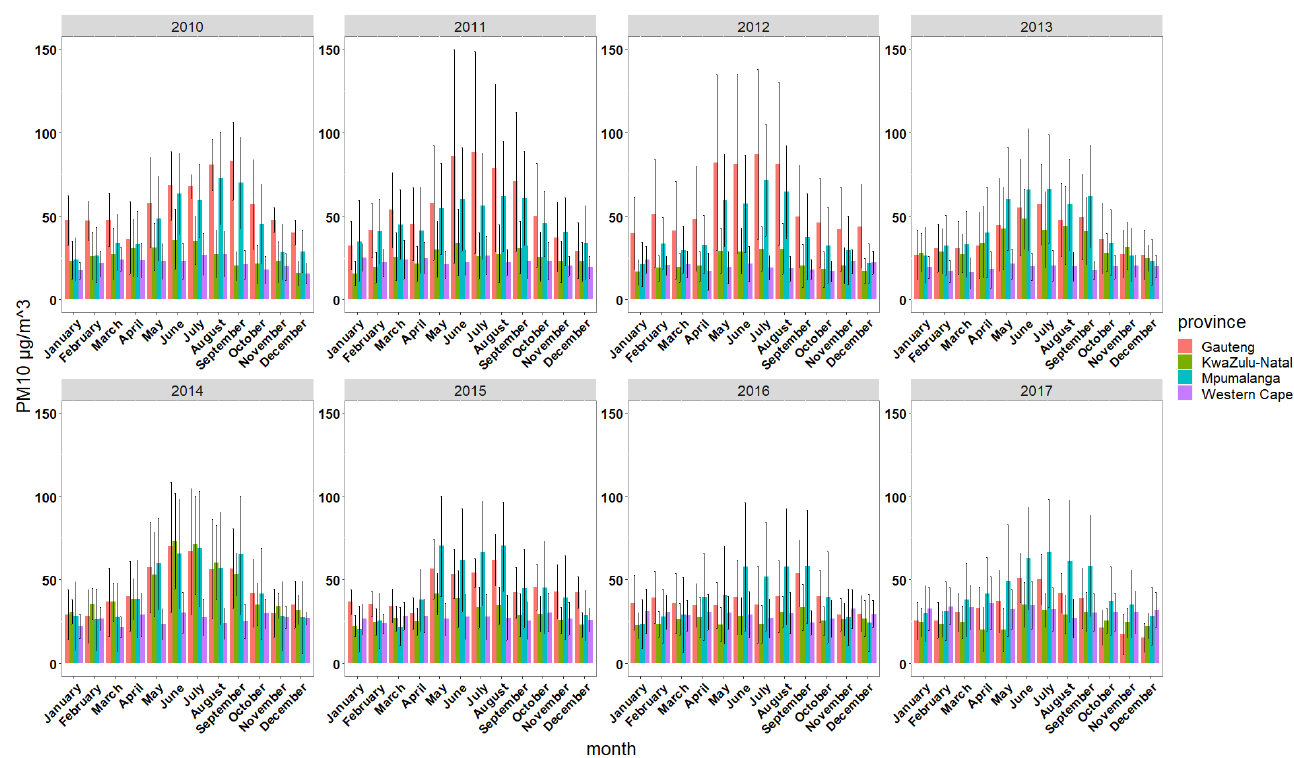
Figure 3. Variations in mean PM 10 µ g/m 3 concentration across the provinces and months of the year. Error bars represent one standard deviation of the mean.